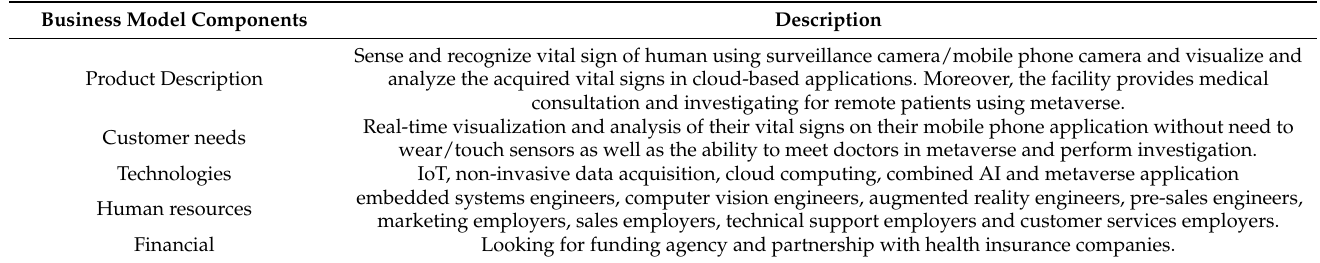
Table 4. Business model for e-healthcare system based on IoT and non-invasive data